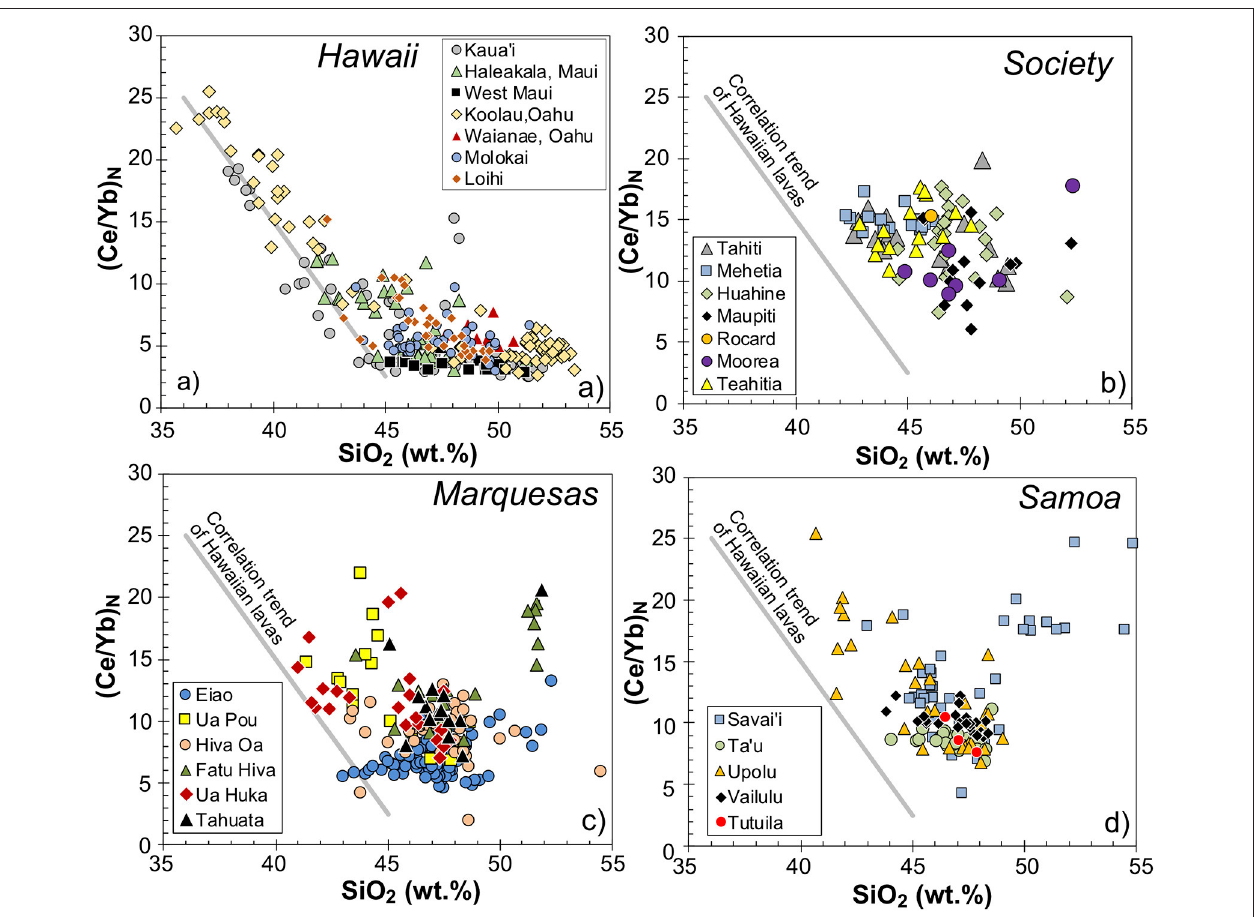
FIGURE 5 | The variation of chondrite-normalized Ce/Yb ratios with SiO 2 contents of the lavas from the (a) Hawaiian, (b) Society, (c) Marquesas, and (d) Samoa hotspots. Note that there is a negative correlation between the (Ce/Yb) N and the lowest SiO 2 content. Different magma series have relatively constant (Ce/Yb) N but crystal fractionation leads to increasing SiO 2 contents. The average trend of the variation observed at Koolau and Kaua’i is shown in all diagrams for comparison. Data sources can be found in the Supplementary Material